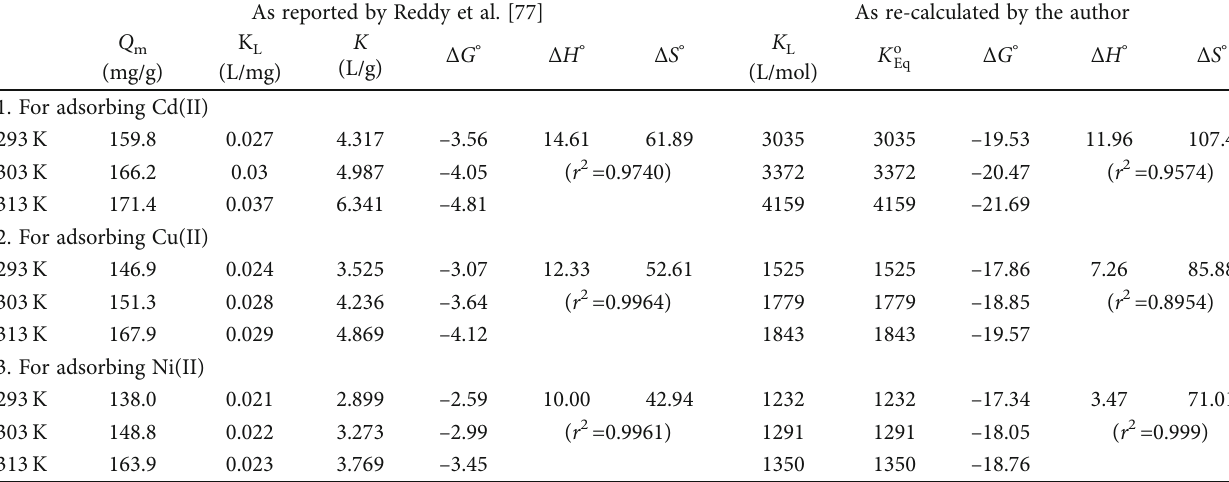
Table 4: Thermodynamic parameters for adsorbing potential toxic metals ions by the modi fi ed-biosorbent. As reported by Reddy et al.